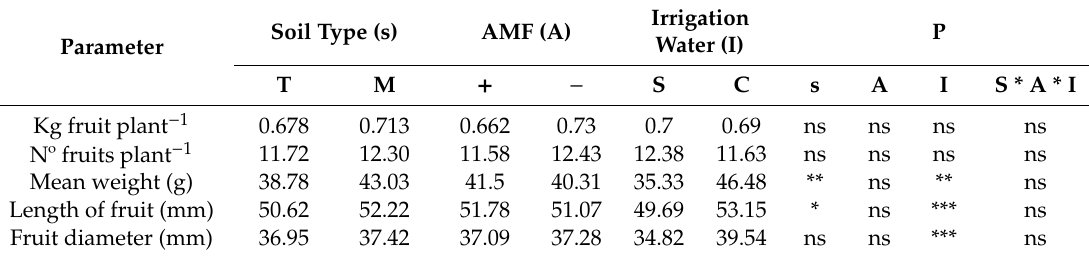
Table 5. Yield and fruit size depending on soil type (s) (traditional: T and mixed: M), AMF inoculation (A) (with: + or without: − ), irrigation water (I) (saline: S, control: C), and interaction among them. Statistical significance according to one-way and three-way ANOVA tests. Values are means of 10